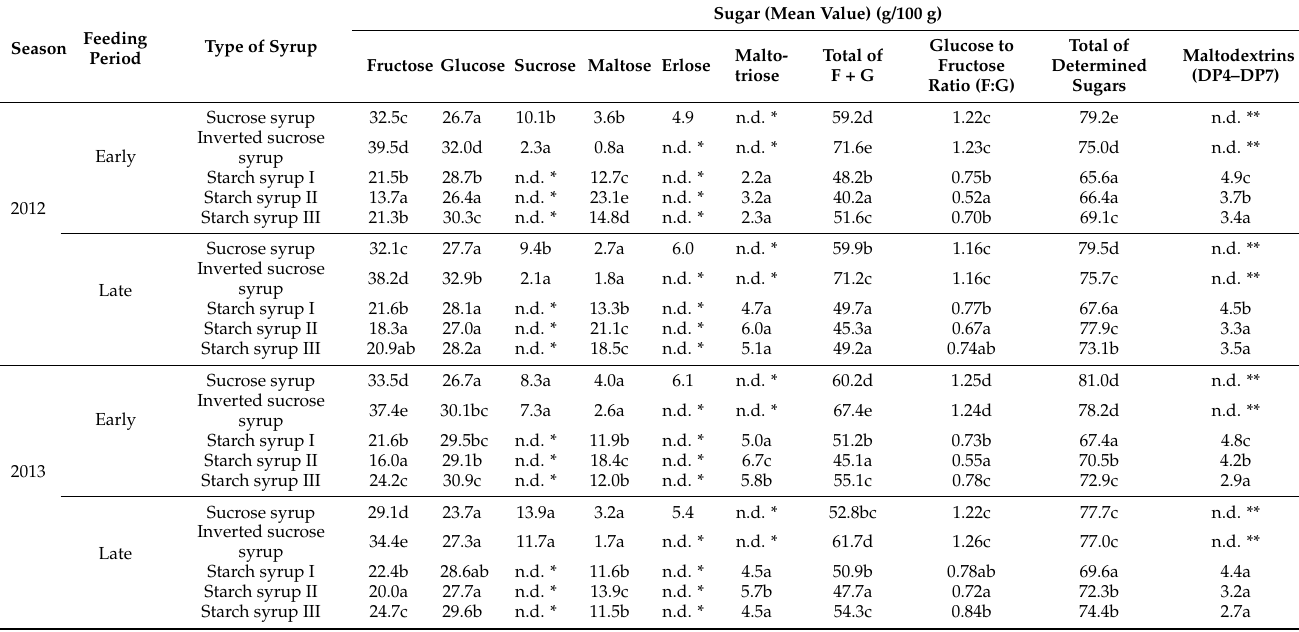
Table 7. Comparison of sugars composition in winter stores ( n = 5) produced by bees fed with different type of syrups in 2012 and